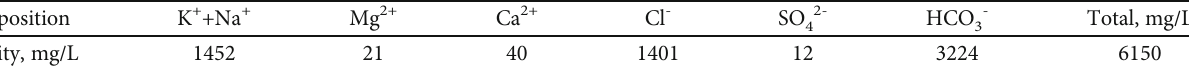
Table 1: Brine ion composition.